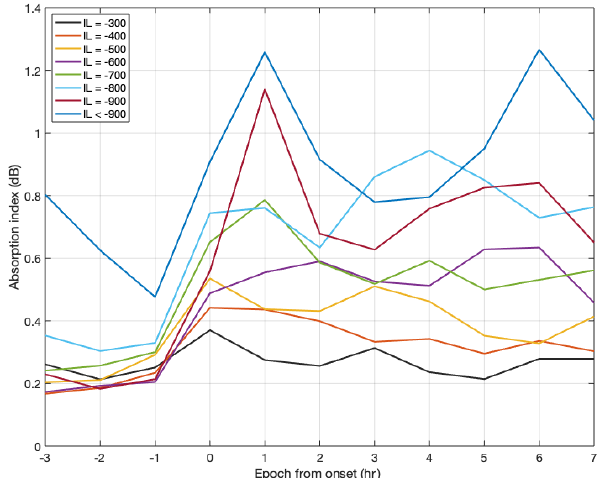
Figure 5. Median CNA curves for different ranges of IL index val- ues without any substorm-type categorization. The intensity catego- rization results in 10–40 events per group. The data are binned into 1h